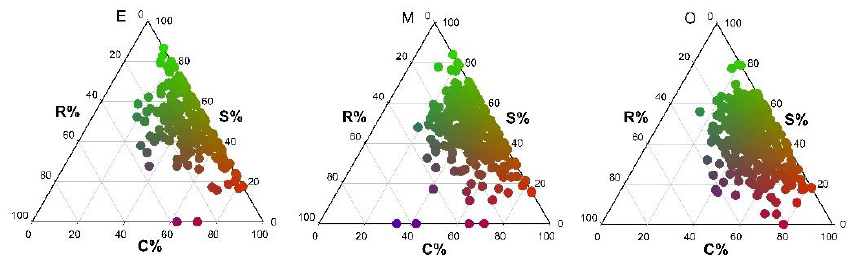
Figure 1. Ternary plots of species ecological strategies for different successional stages in tropical lowland rainforests on Hainan Island (E = early succession, M = mid-succession and O = late succession). C (%), S (%) and R (%) represent the three strategy components C, S and R, respectively. Ecological strategies are represented by color: pure red indicates the C strategy, pure green indicates the S strategy, and pure blue indicates the R strategy. Intermediate (mixed) colors indicate the full range of intermediate strategies (e.g., green/blue = SR strategy).